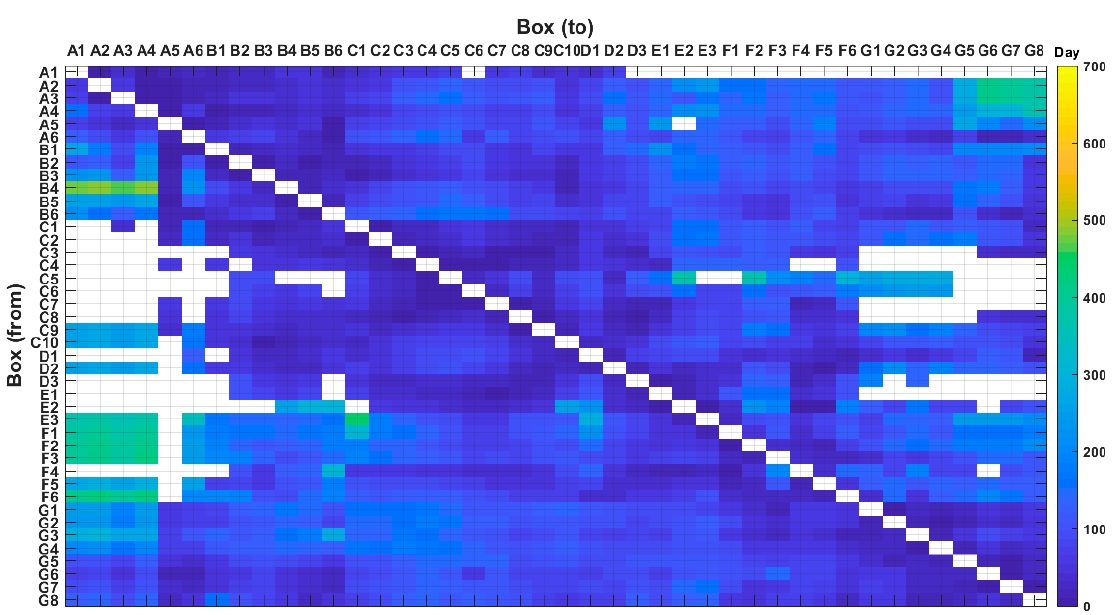
Figure 6. Mean transit time of drifters connecting the 42 boxes of the WMED. Each box extends over a 1° × 1° cell. Drifter data refer to the 1985–2016 period.